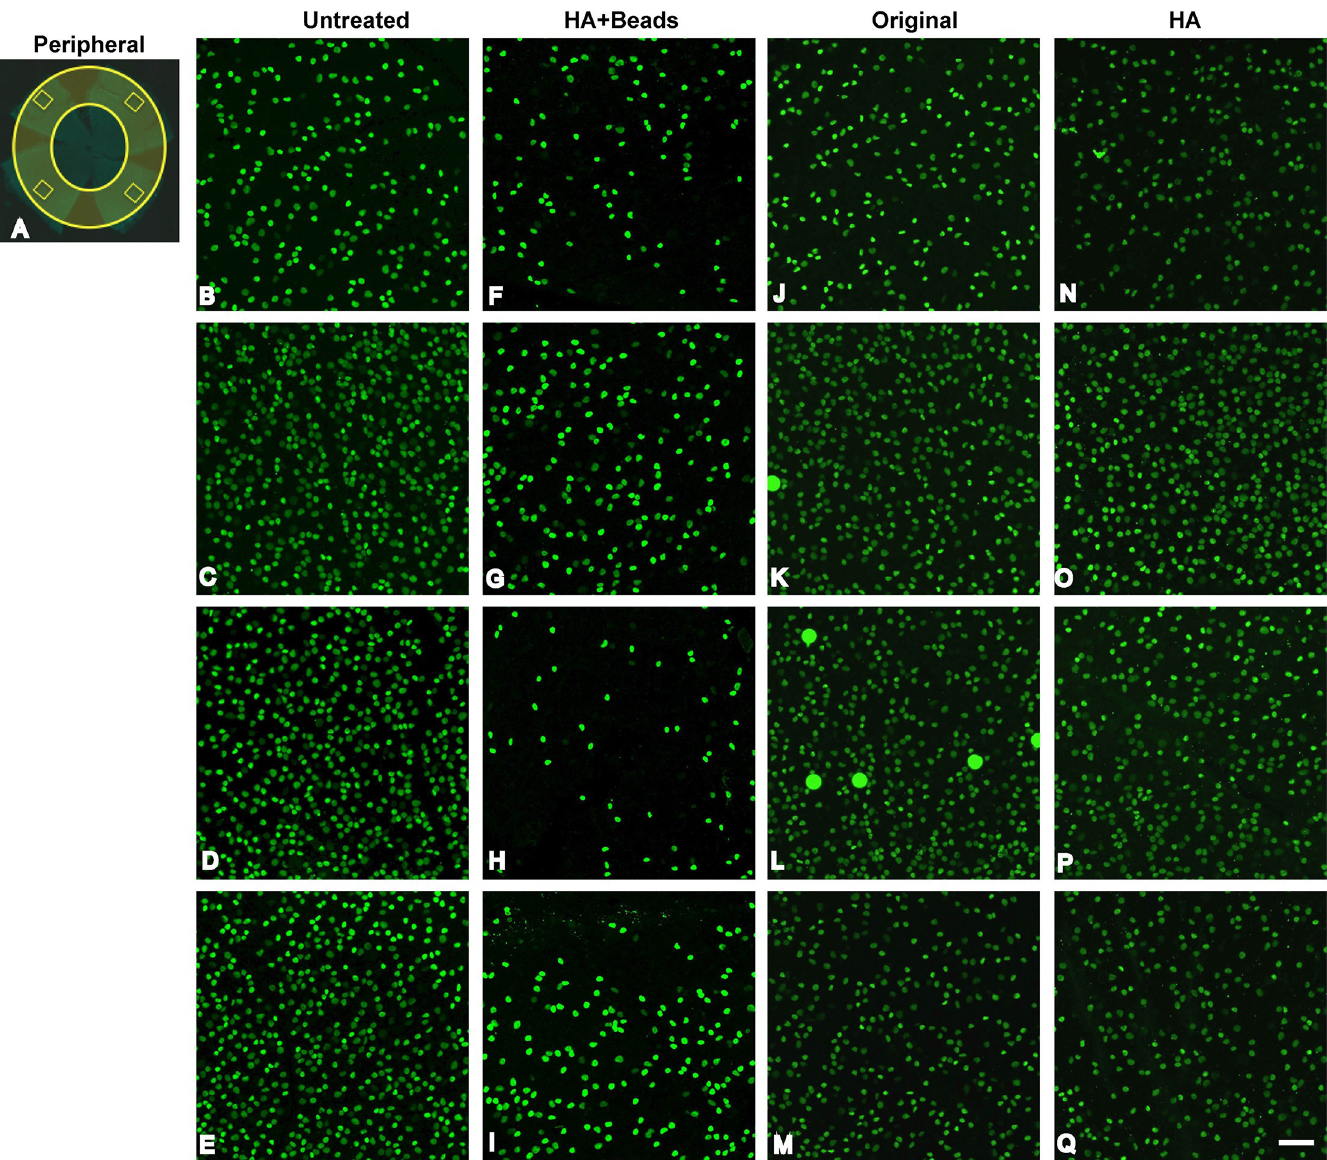
Fig 4. RGC damage in the peripheral retina from each experimental group. (A) Damage assessment approach. After immunostaining whole retinal flatmounts with Brn-3a, a RGC-specific marker, four areas in the periphery (yellow outlined rectangles in the yellow circle) were selected to determine RGC density. (B-E) Confocal microscopic images from the selected retinal areas in normal, untreated C57BL/6J mice immunostained with Brn-3a. Retinal selections from the HA+Beads group (F-I), original group (J-M), and HA group (N-Q) at 30 days post-injection. Scale bar = 50 μ